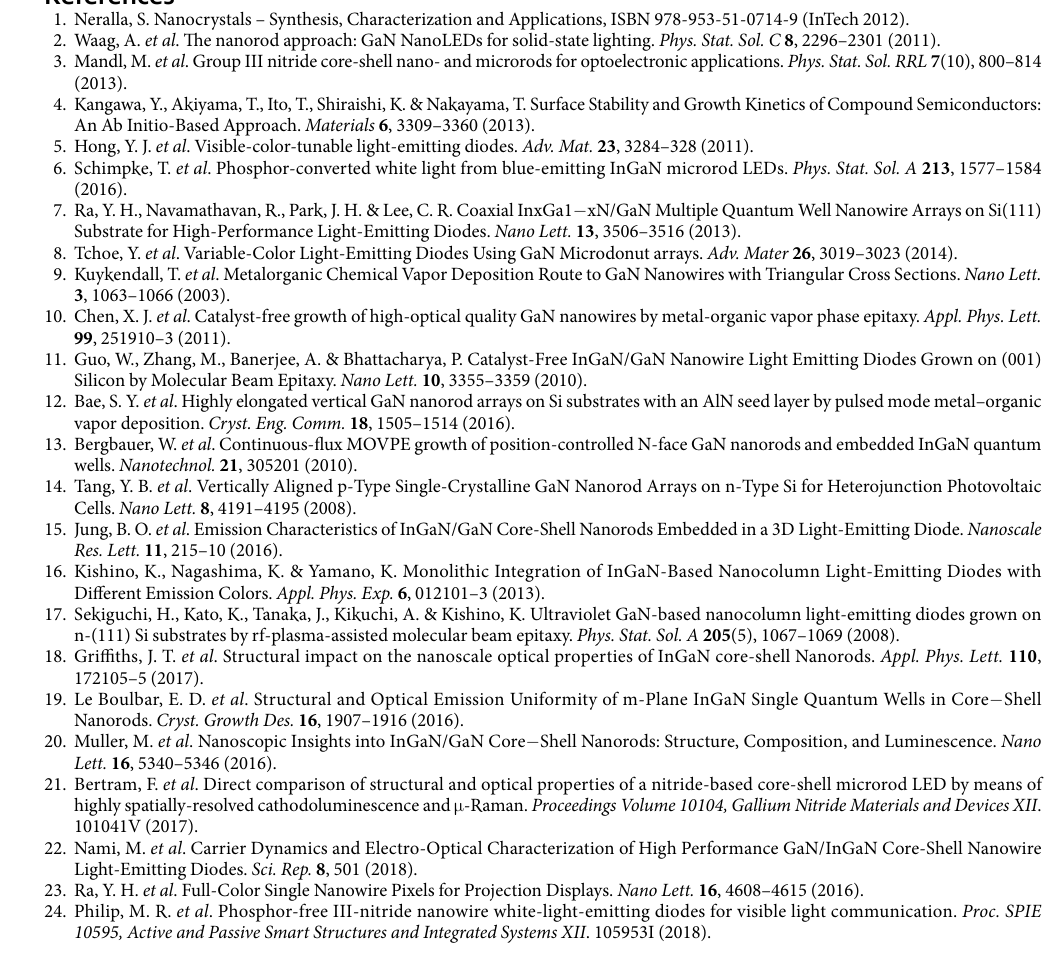
7 SCIENTIFIC RePoRts | (2018) 8:7311 | DOI:10.1038/s41598-018-25473-x